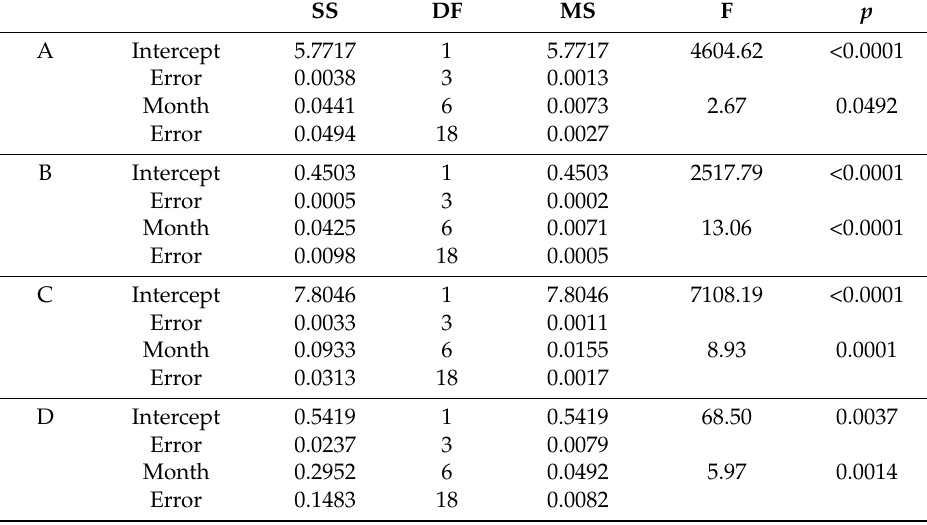
Table 2. Repeated measures ANOVA of chemical defence of Z. marina against A: B. aquamaris ; B: A. stellipolaris ; C: L. rosea ; D: P. dokdonensis . Within-measures factor was the month of